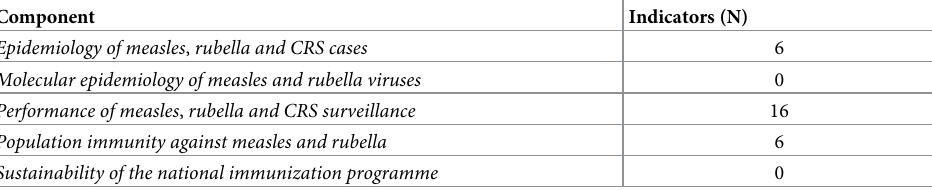
Table 1. Number of indicators identified in each core component of the ASU’s